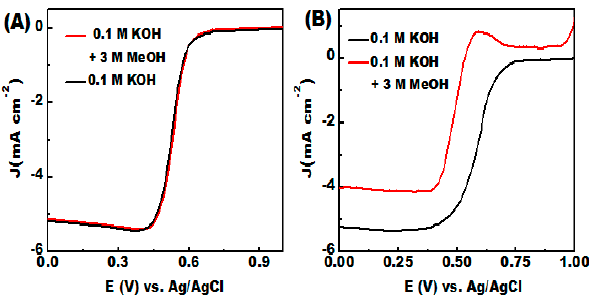
Figure 8. ( A , B ) Catalytic selectivity characterization measured in O 2 saturated 0.1 M KOH solution